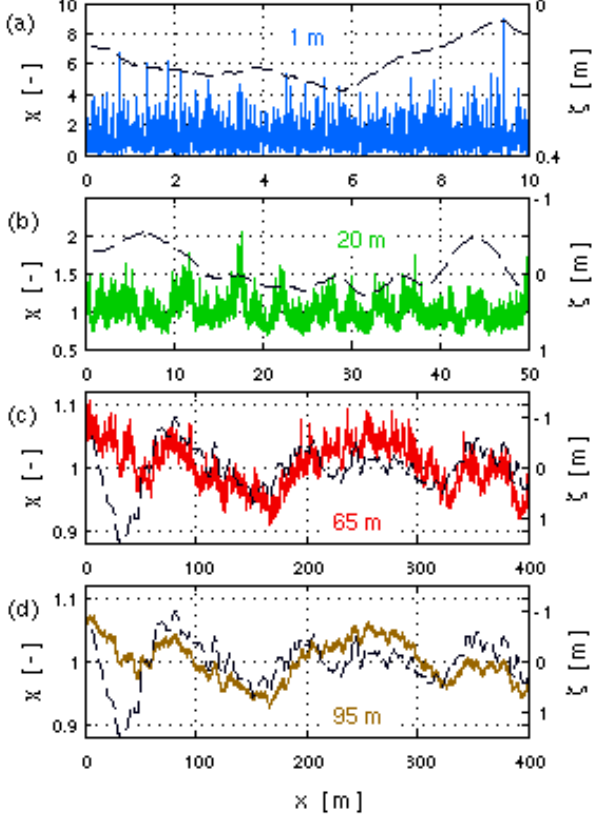
2 Fig. 6. Normalized downwelling irradiance χ at four different water depths with (a) 2.5mm, (b) 1cm, and (c) and (d) 10cm horizontal Figure 6. Profiles of nNormalized downwelling irradiance χ at four different water 3 grid resolution; on the right ordinate (dashed) is the corresponding surface elevation (30 October depths with (a) 2.5 mm, (b) 1 cm, and (c) and (d) 10 cm horizontal grid resolution; on the 4 right ordinate (dashed) is the corresponding surface elevation (30 Oct. 2009). 5 6